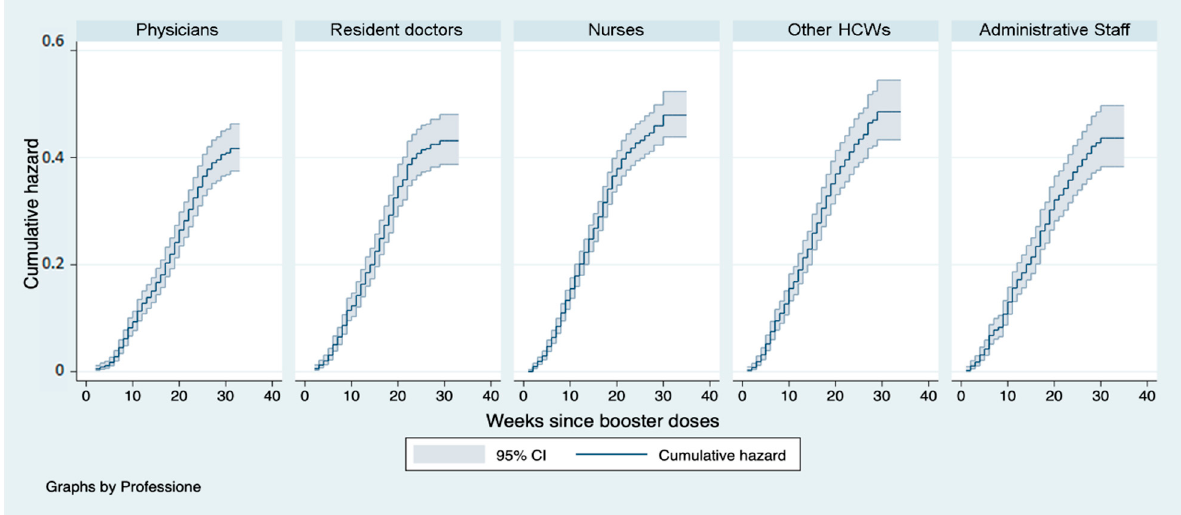
Figure 5. Nelson–Aalen cumulative hazard estimates: curves representing the cumulative risk of infection after booster dose stratified by occupational category in the follow-up period.